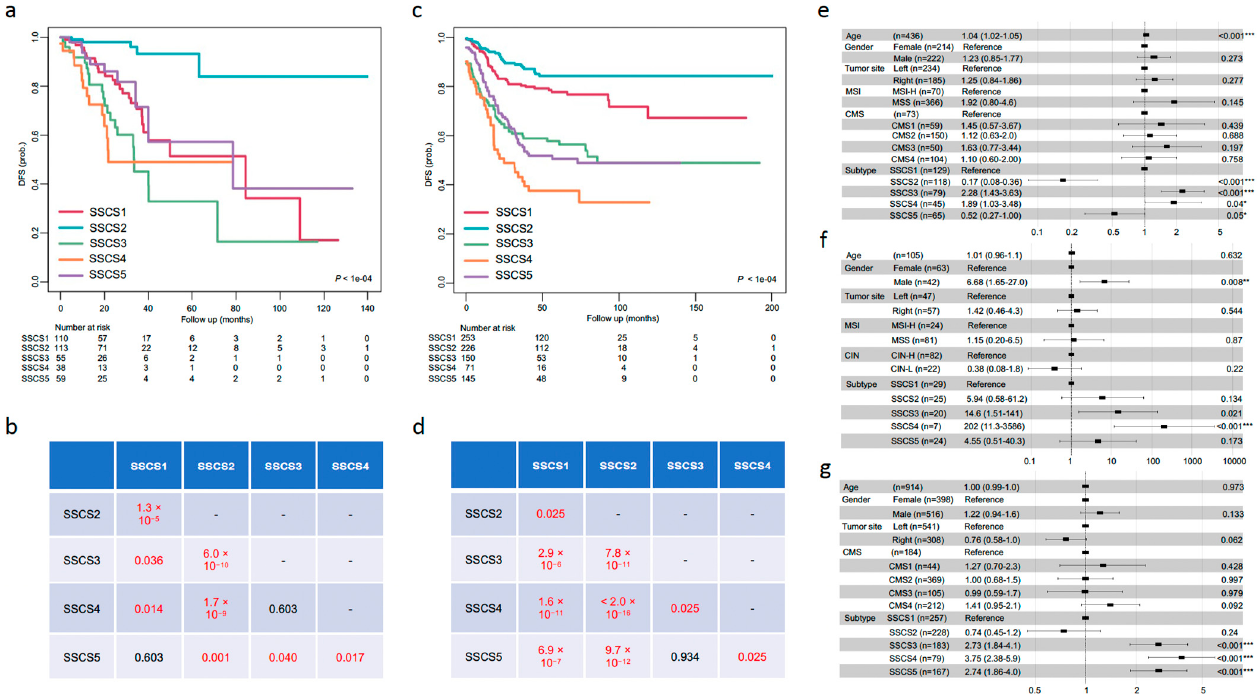
Figure 5. SSCS subtypes clinical characteristics. Kaplan–Meier survival curves comparing DFS of the five SSCS subtypes in the TCGA ( a ) and GEO ( c ) cohorts. The indicated p -values were calculated with the log-rank tests. Summary tables of the pairwise comparisons of survival curves between the five SSCS subtypes in the TCGA ( b ) and GEO ( d ) cohorts. Survival differences were tested using the log-rank tests, with FDR adjusted p -values less than 0.05 were considered statistically significant and displayed in red colors. Forest plots of Cox PH regression models illustrated the HRs, 95% CIs and log-rank p -values for different subtyping systems (SSCS, MSI, CMS, etc.) and confounder factors (age, gender, etc.) for DFS in the TCGA ( e ), CPTAC ( f ), and GEO ( g ) cohorts. Log-rank p -value significance levels were given by stars: * <0.05, ** <0.01, and *** <0.001.